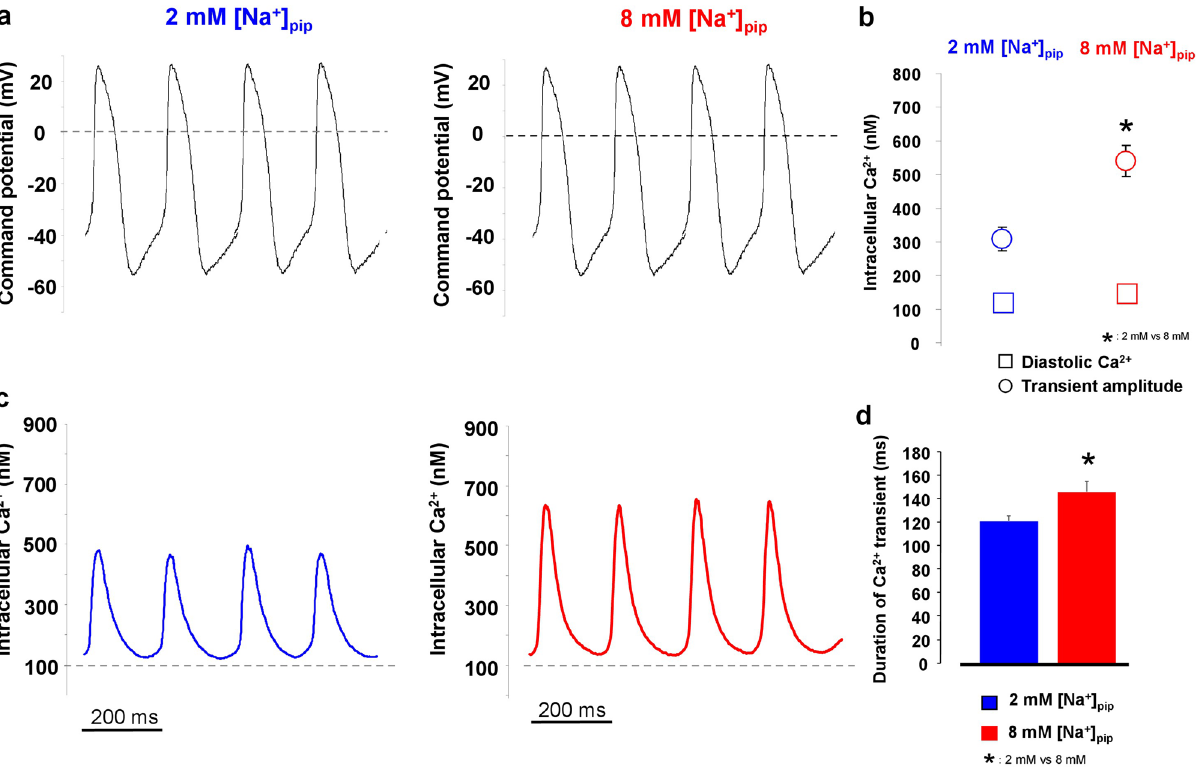
Figure 3. An estimation of Ca 2+ transients under a canonical SN action potential command potential in the presence of 2 mM (left) and 8 mM (right) NaCl in the pipette solution. The compositions of the extra and intracellular solutions ensured that K-currents, I f , and Na/K pump were inhibited during these measurements. The intracellular Ca 2+ was unbuffered. Panel ( a ) represents a canonical AP command potential. The